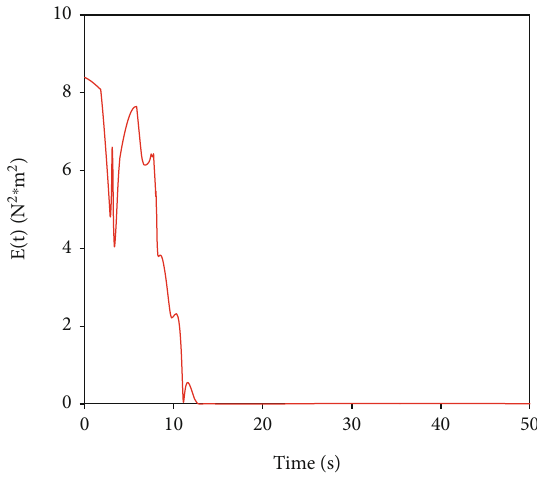
Figure 8: Time response of energy consumption by using the controller design idea in Ref.